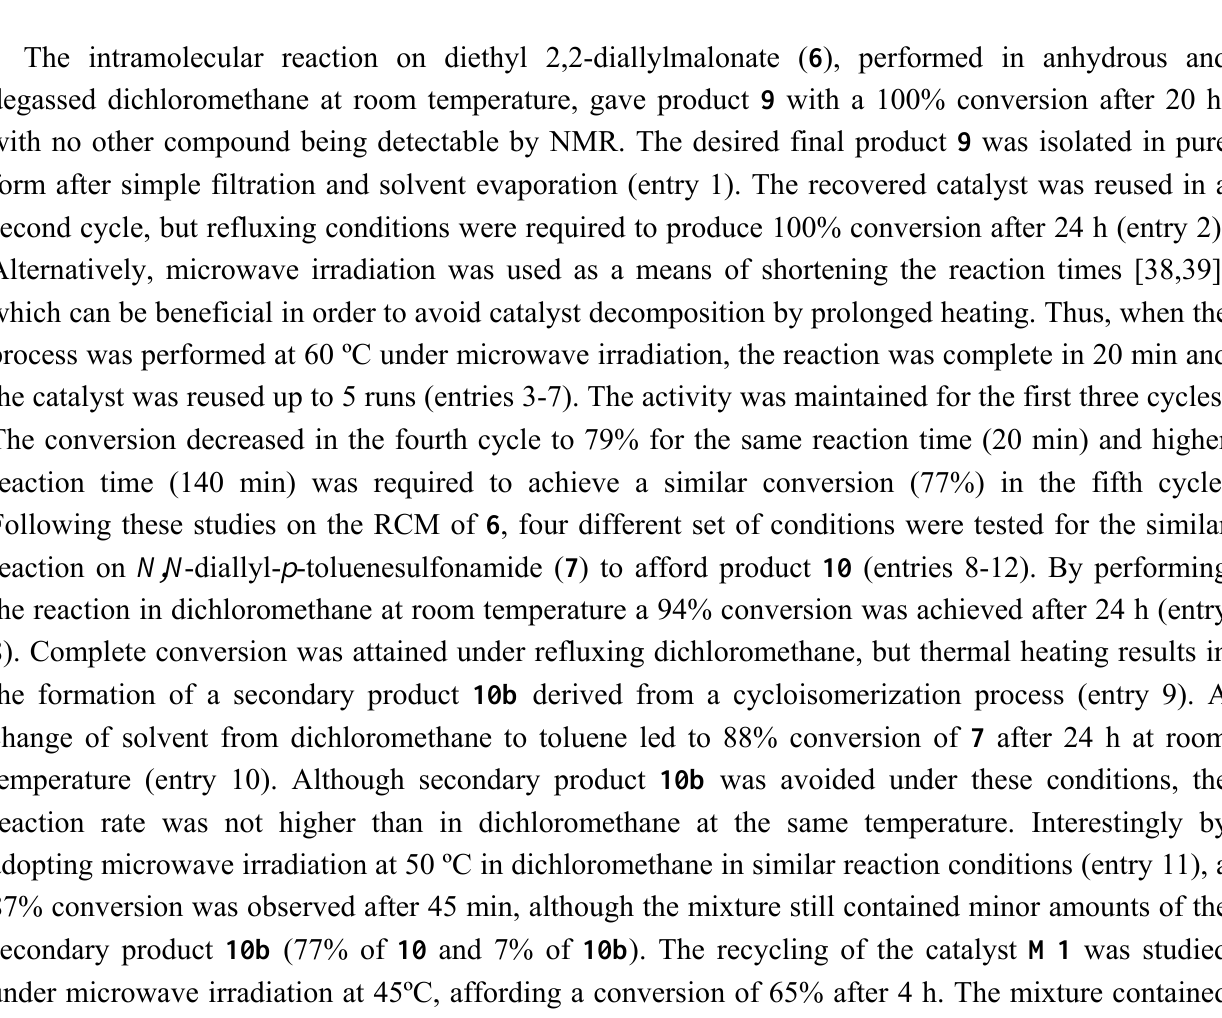
a General conditions: anhydrous and degassed solvent, inert atmosphere, 3.5 mol% of Ru, [substrate] = 0.05 M. b Conversion determined by NMR, only the desired product being formed unless otherwise stated. c Microwave irradiation with PowerMax option enabled. d 82% of 10 and 18% of the cycloisomerization product 10b. e 77% of 10 and 7% of the cycloisomerization product 10b. f 63% of 10 and 2% of the cycloisomerization product